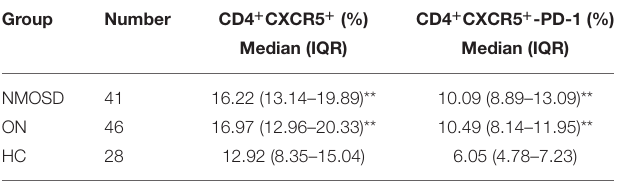
TABLE 2 | Changes of circulating follicular helper T cell percentages in idiopathic ON and NMOSD group.